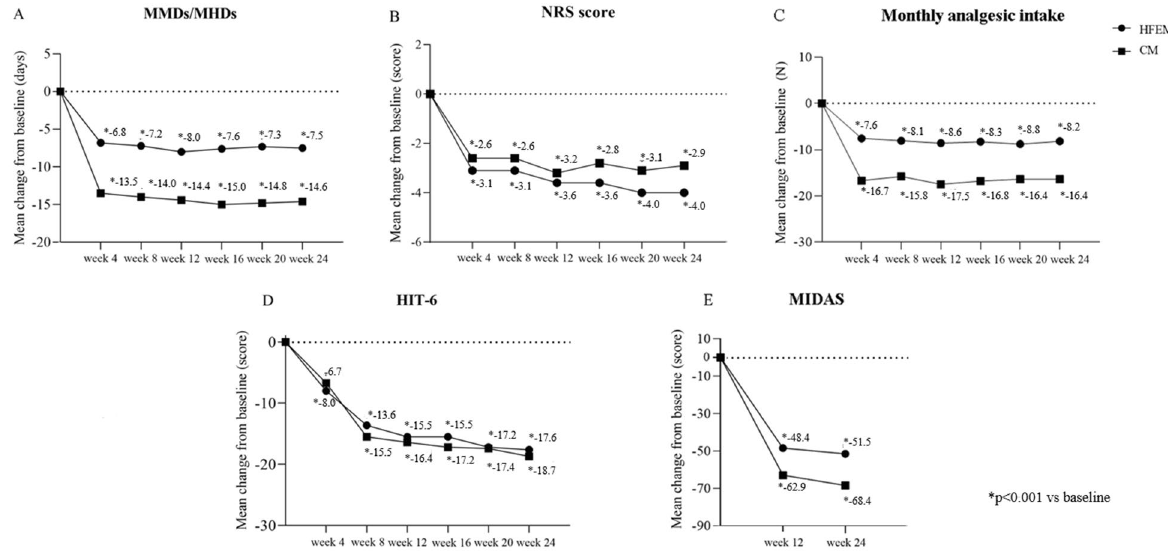
Fig. 6 Mean change in ( A ) monthly migraine days/monthly headache days (MMDs/MHDs), B Numerical Rating Scale (NRS) score, C monthly analgesic medications, D Headache Impact Test-6 (HIT-6) score and (E) Migraine Disability Assessment Scale (MIDAS) score from baseline to week 24 in patients from headache centers providing efficacy data at weeks 4, 8, 12,16, 20 and 24 ( n chronic